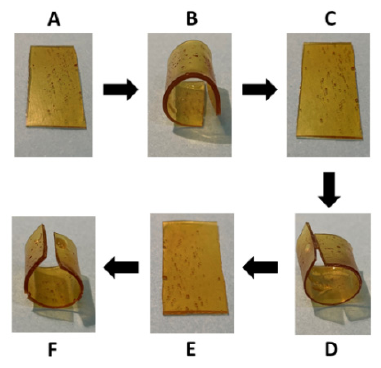
Figure 11. Reprogrammable shape memory cycle for sample 5050DSS. ( A ): Initial permanent shape. ( B ): First temporal shape. ( C ): Recovered shape. ( D ): Reprogrammed permanent shape. ( E ): Second temporal shape. ( F ): Second recovered shape.